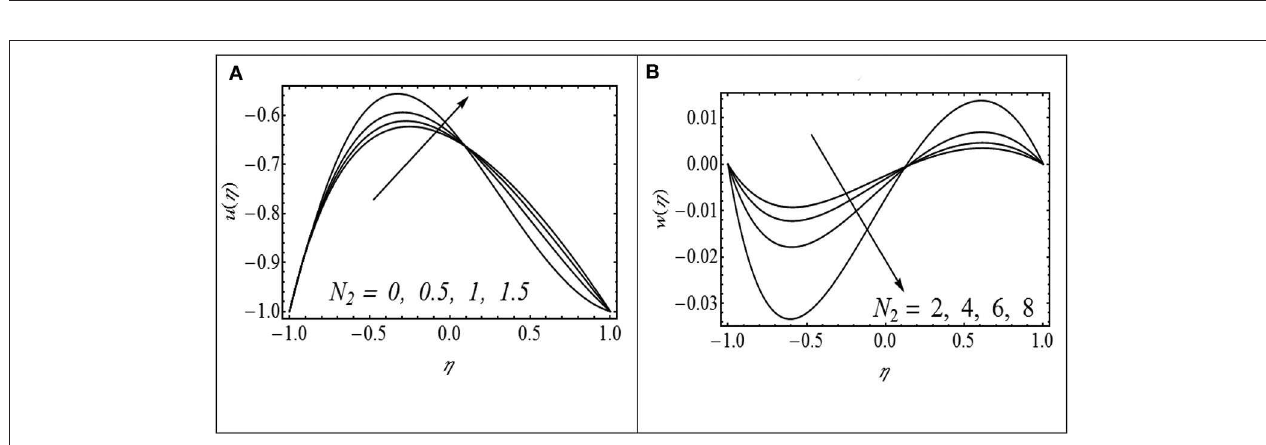
FIGURE 4 | (A,B) Impact of N 2 on u (η) with γ = 2.5, Ha = 2, N 1 = 0.5, λ = 0.4, and 2 = 1.5. (B) Impact of N 2 on w (η) with γ = 2.5, N 1 = 0.5, λ = 0.4, and 2 = 1.5.